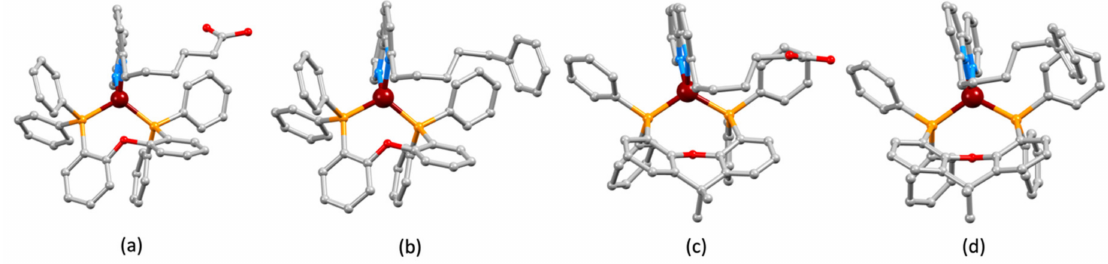
Figure 3. The energy minimized structures of the cations ( a ) [Cu(POP)( 1 )] + , ( b ) [Cu(POP)( 2 )] + , ( c ) [Cu(xantphos)( 1 )] + and ( d ) [Cu(xantphos)( 2 )] + .